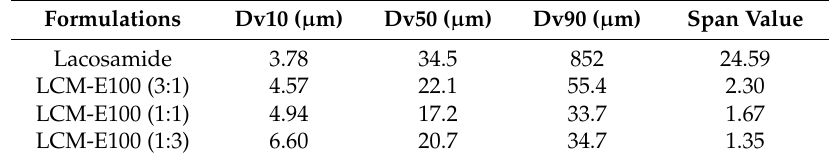
Table 2. Particle size distribution of lacosamide, LCM-E100 (3:1), LCM-E100 (1:1), and LCM-E100 (1:3).